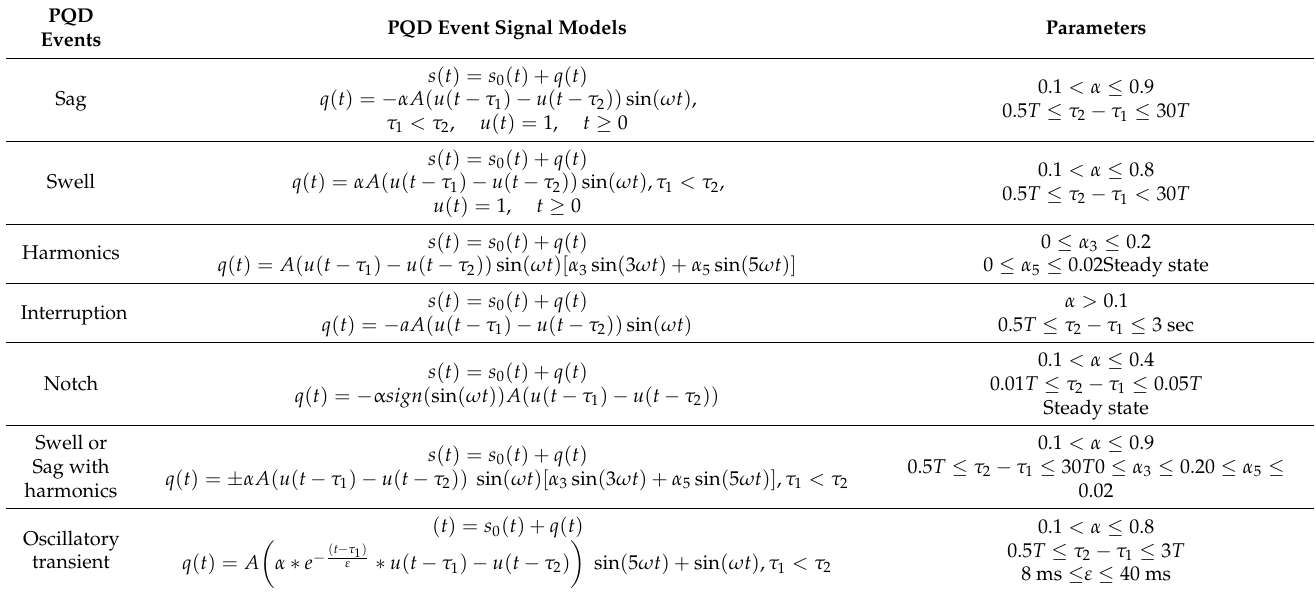
Table 1. Power quality disturbance (PQD) event signal models and